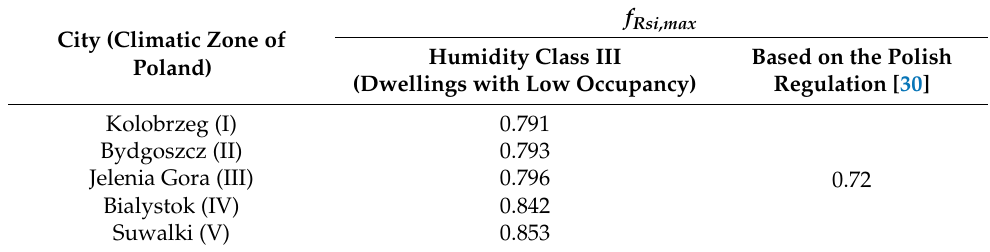
Table 4. Critical temperature factor for five selected cities in each of the five climatic zones of